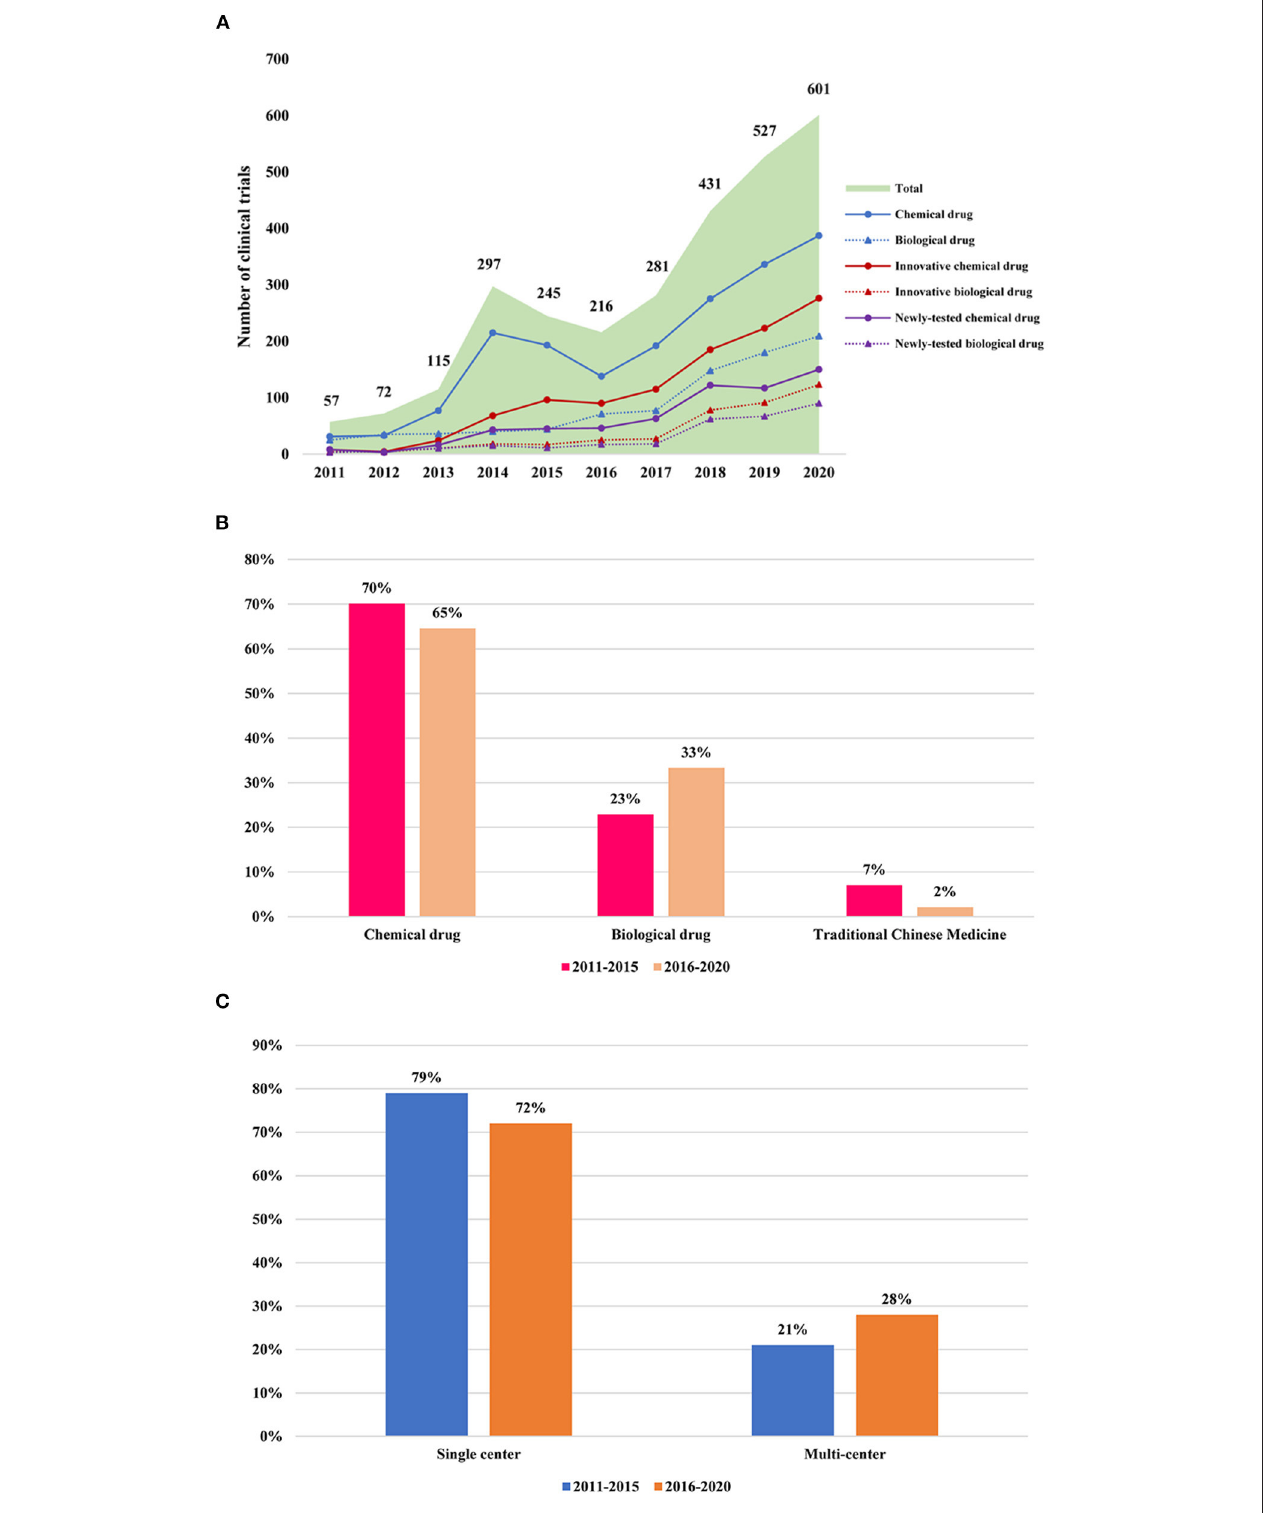
FIGURE 2 | Change of phase I clinical trials in mainland China during 2011–2020. (A) Annual change of phase I clinical trials in mainland China during 2011–2020. The data cutoff date was December 30, 2020; (B) The changes of the chemical drug, biological drug, and traditional Chinese medicine every 5 years; (C) The changes of a single center and multicenter design every 5